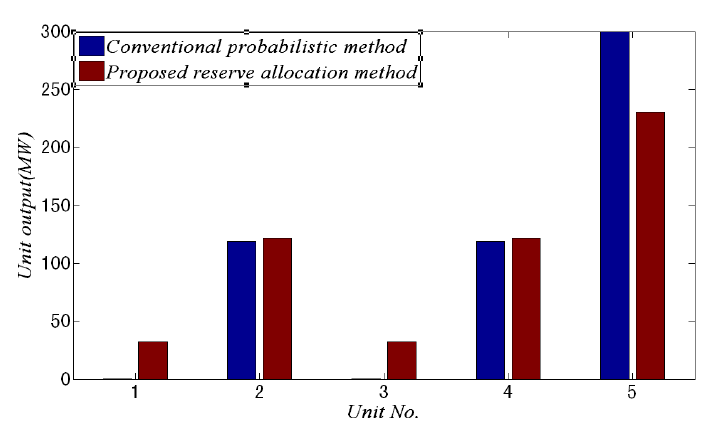
Figure 10. Active power output of the units in sub-area